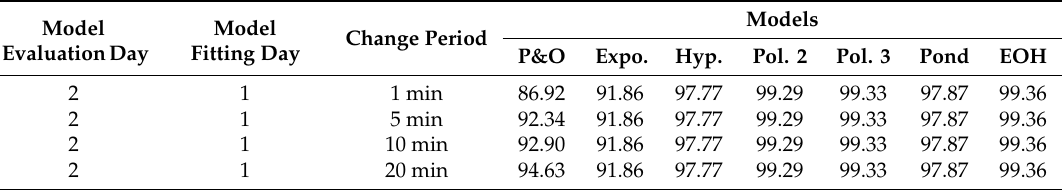
Table 6. Obtained performances (percentage of tracking e ffi ciency) with di ff erent load change